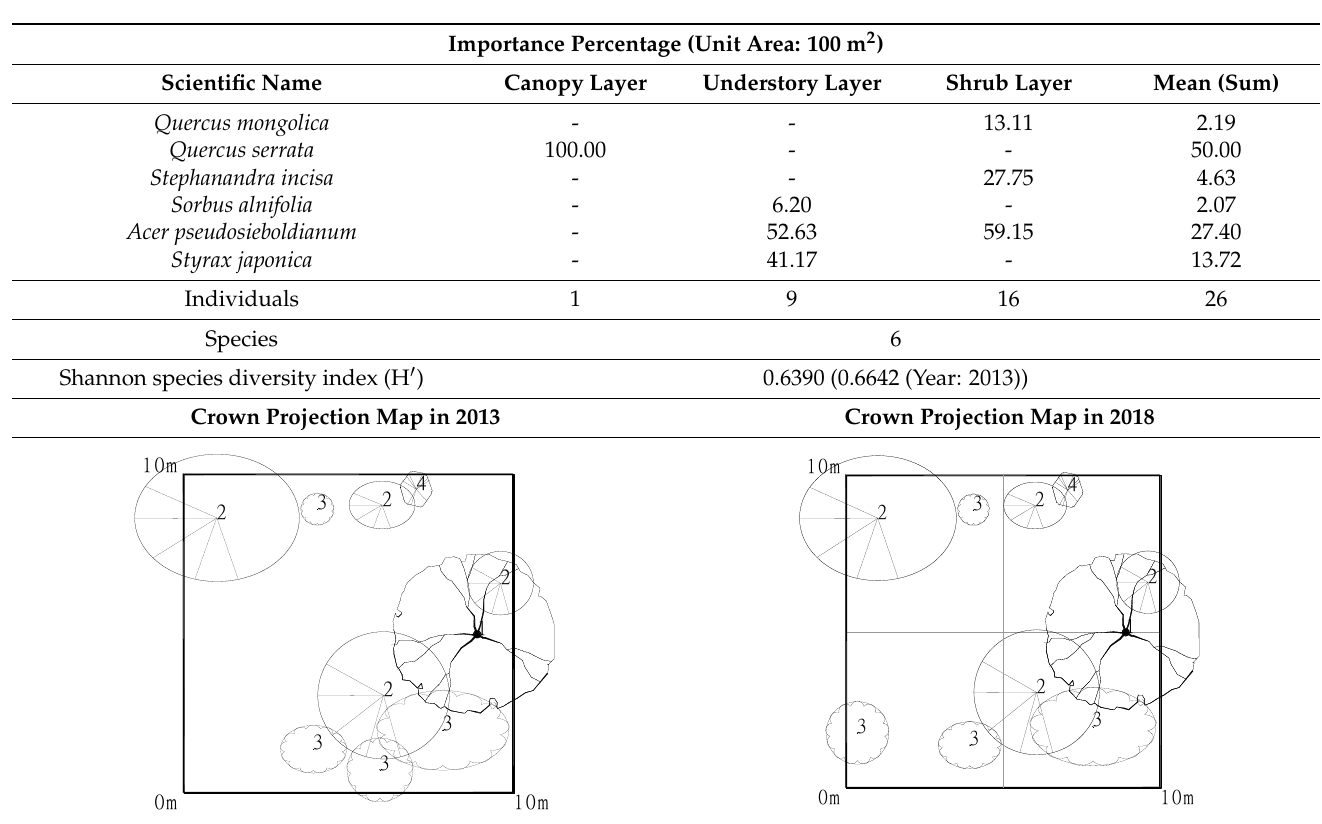
Table 4. Plant community structure of the Quercus serrata community (survey plot no. 7) in the forest of the Changdeokgung Rear Garden.